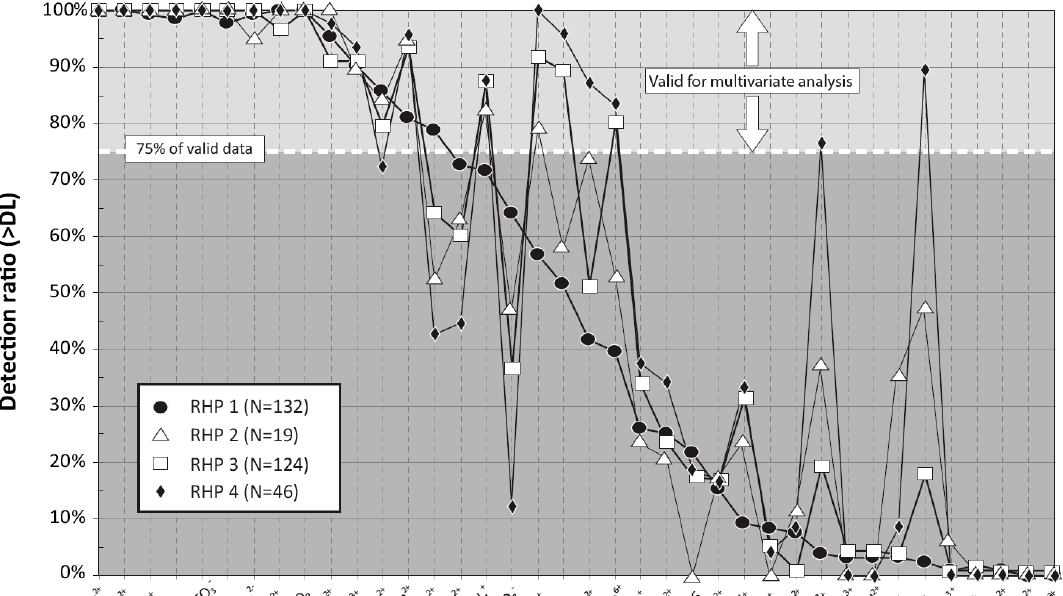
Figure 4. Line graph of the percentage of valid data (i.e., above the detection limit) for each regional hydrogeochemical pole (RHP 1: HCO 3 _ Gran; RHP 2: Cl_Gran; RHP 3: HCO 3 _Rock; and RHP 4: Cl_RockAq group).